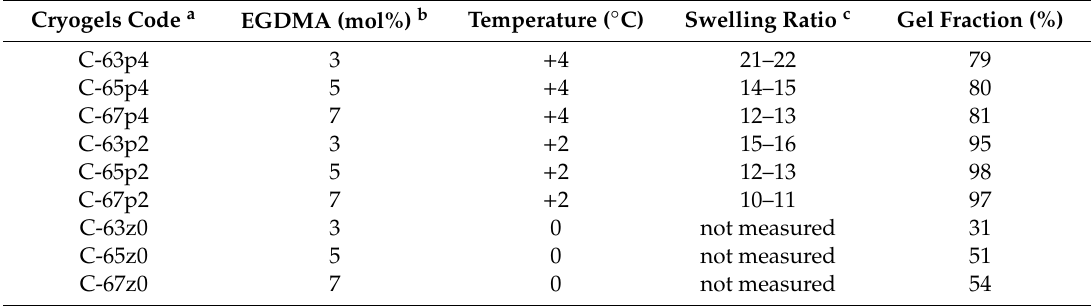
Table 1. Cryo-Polymerizations for the Preparation of P(LA- co -EGDMA) Cryogels at [M] 0 = 0.6 mol /